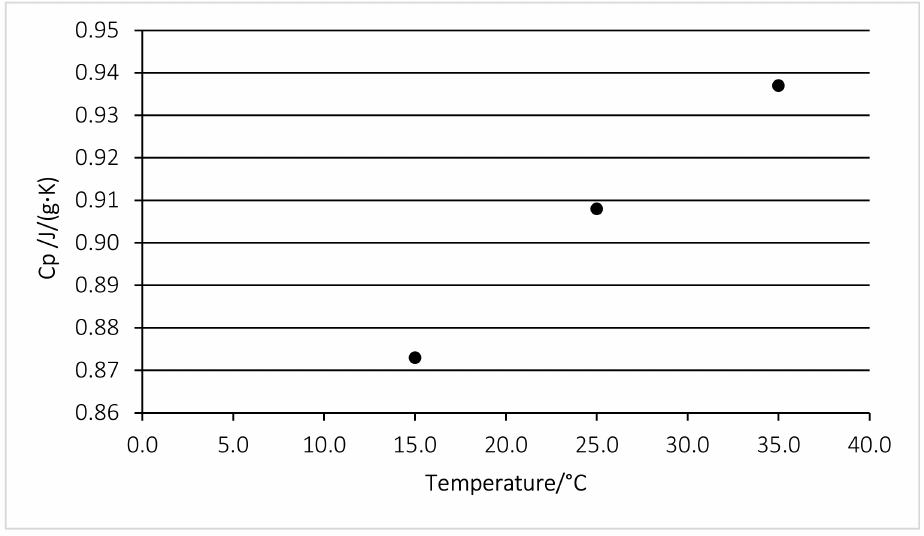
Figure 5. Specific heat measurements. It should be taken into consideration that in case of lightweight structures the em- bedded ducts can have negative impact in comparison to retrofitting the existing heavy weight constructions. Analysis of three cases is shown in Table 3. Indoor and outdoor temperatures for the calculation model were set as follows: indoor (+20 ◦ C) and outdoor ( − 10 ◦